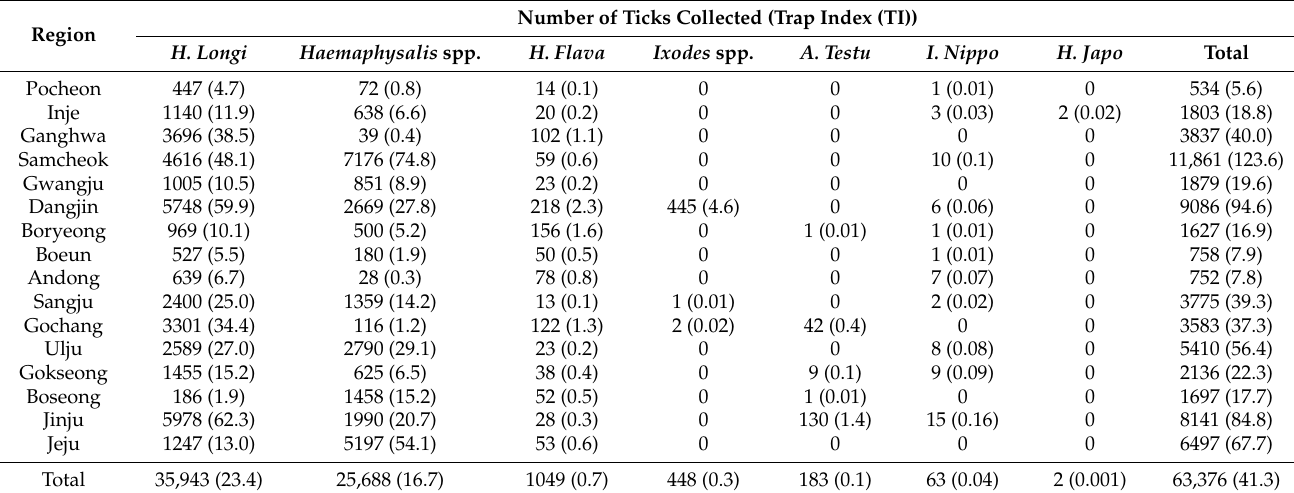
Table 1. Geographical distribution of tick species collected from traps in Korea in 2020. Number of Ticks Collected (Trap Index (TI)) Region H.